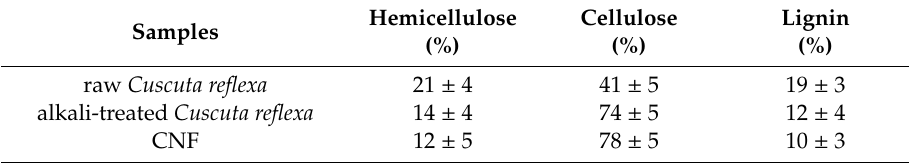
Table 2. Chemical composition analysis of cellulose nanofiber (CNF) at each stage of treatment.